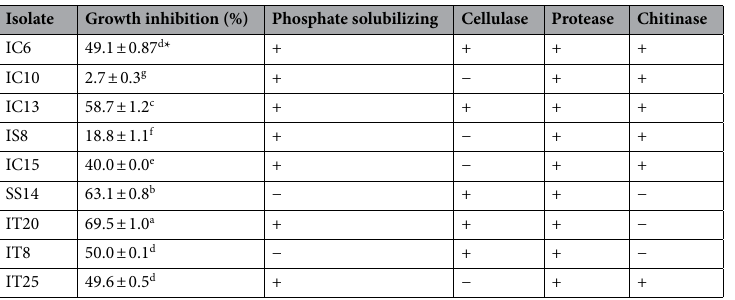
interactions among biocontrol strains of Streptomyces introduced, different genera of beneficial microbes, and native microbial communities in the rhizosphere of healthy plants. On the other hand, the effects of phosphate